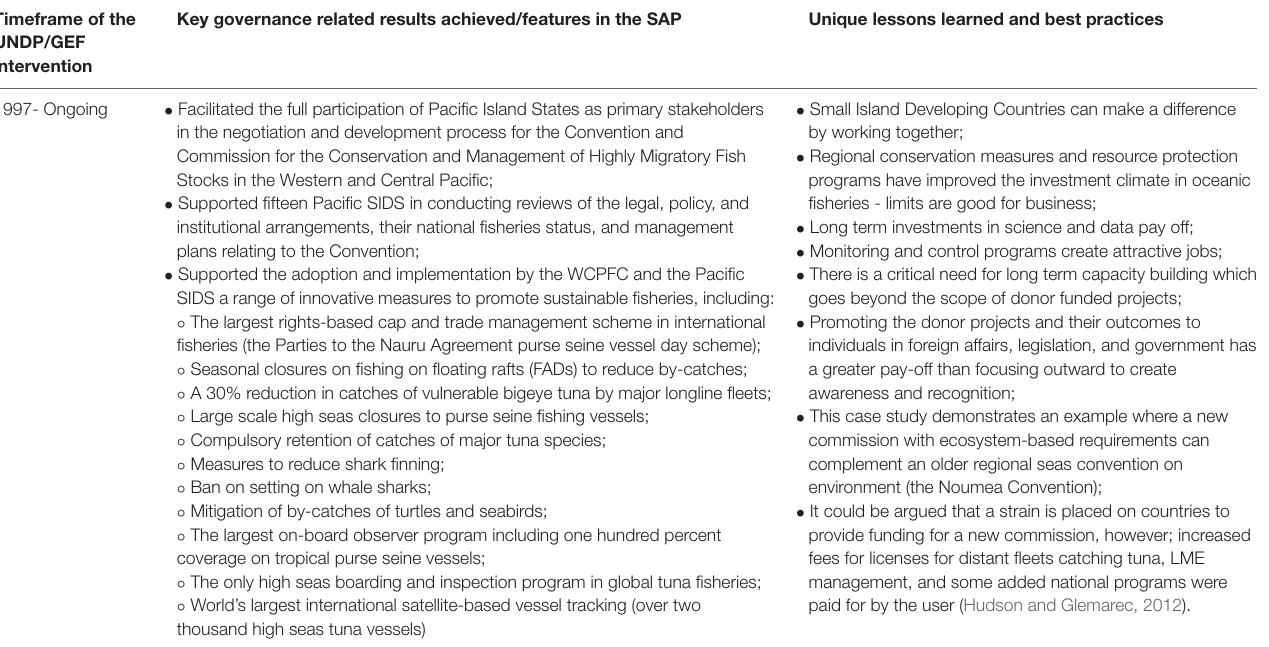
TABLE 5 | Highlighted results of the TDA-SAP process and LME Approach in the Western Tropical Pacific Warm Pool LME, as well as unique lessons learned from the intervention (Tortell and Tarte, 2004; United Nations Development Programme, 2011; Chapman and Fong, 2018). Timeframe of the Key governance related results achieved/features in the SAP Unique lessons learned and best practices UNDP/GEF intervention 1997-